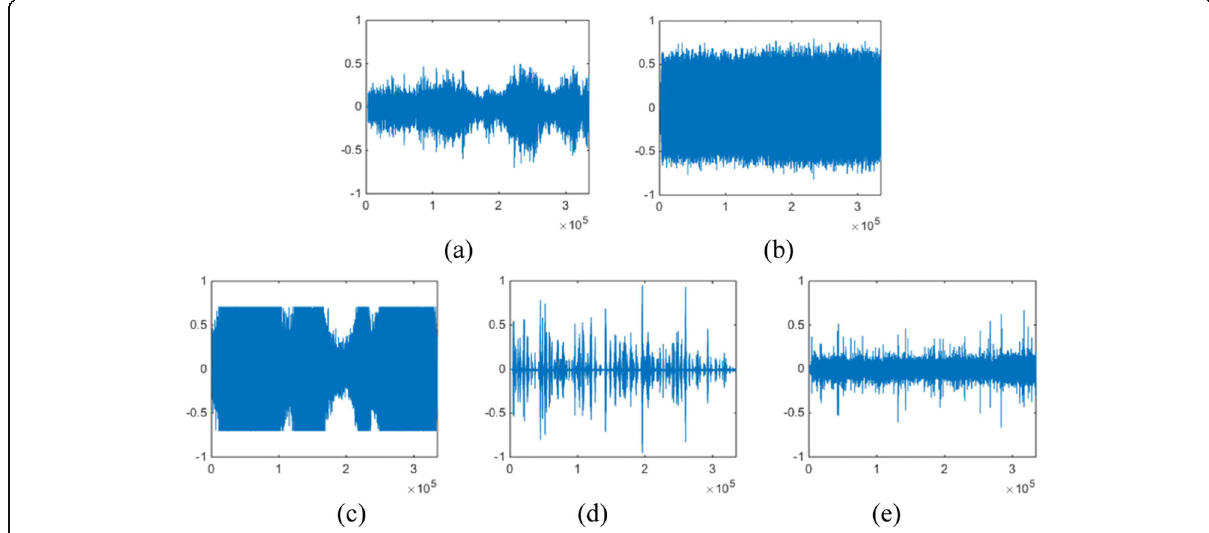
Fig. 15 Amplitude spectrum before normalization: a drone, b plane, c car, d bird, and e